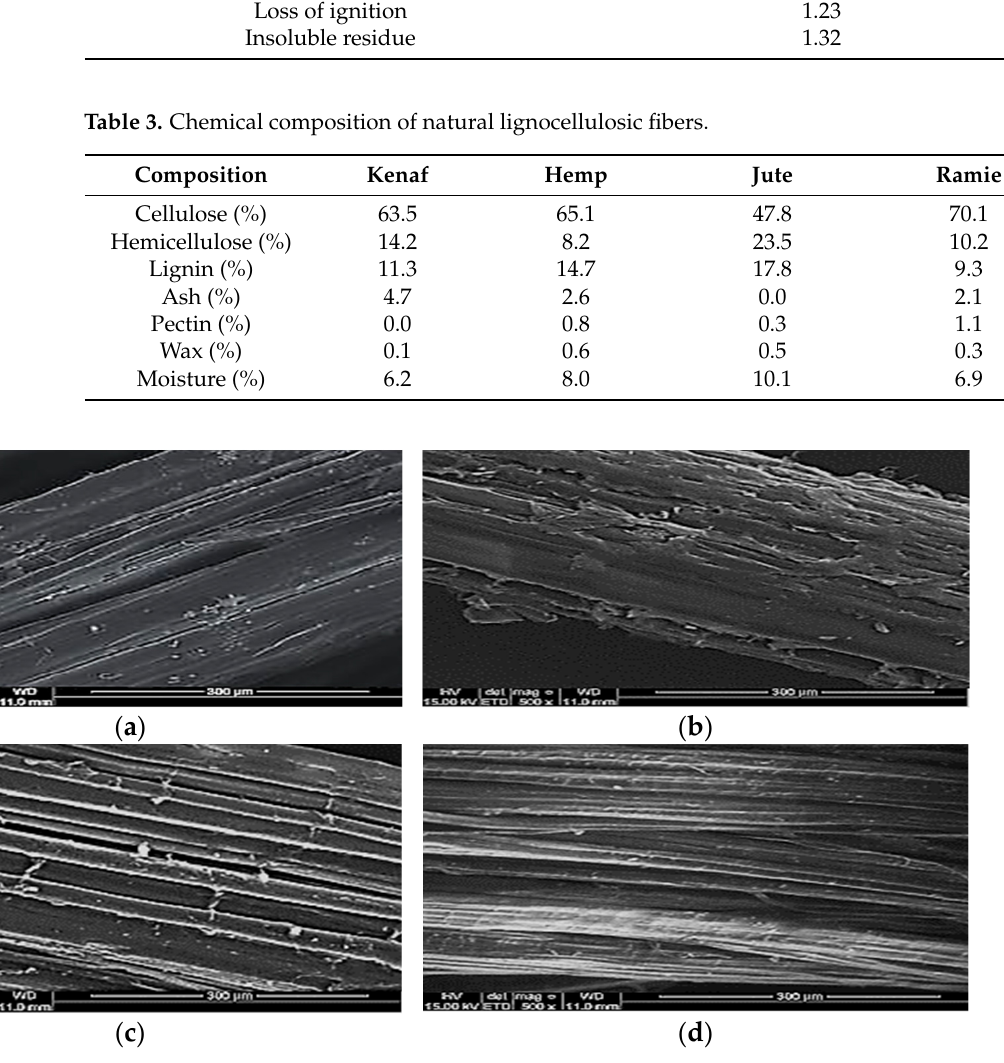
Figure 2. SEM micrograph of lignocellulosic plant fibers. ( a ) kenaf fiber; ( b ) hemp fiber; ( c ) ramie fiber; ( d ) jute fiber.